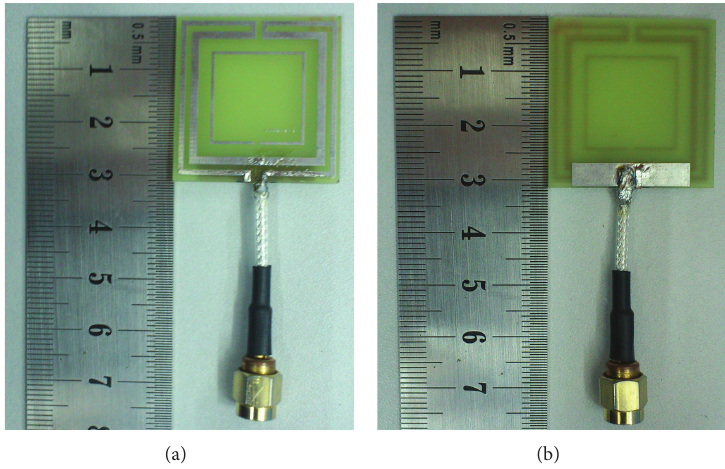
Figure 5: Photograph of antenna prototype. (a) Top view, (b) bottom view.